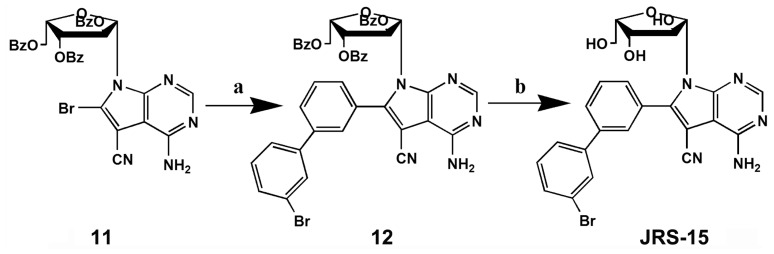
Reagent and condition: (a) Pd(PPh3)4, 3-bromophenyl boronic acid, K2CO3, toluene; (b) NaOCH3/CH3OH.